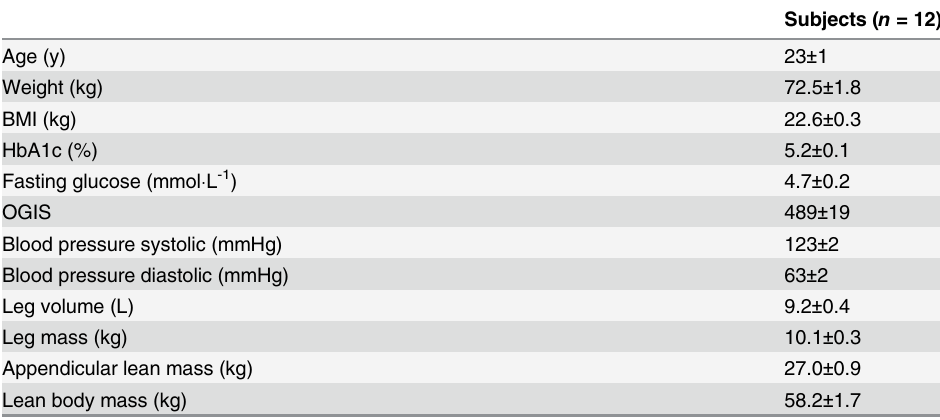
Table 1. Subjects ’ characteristics.